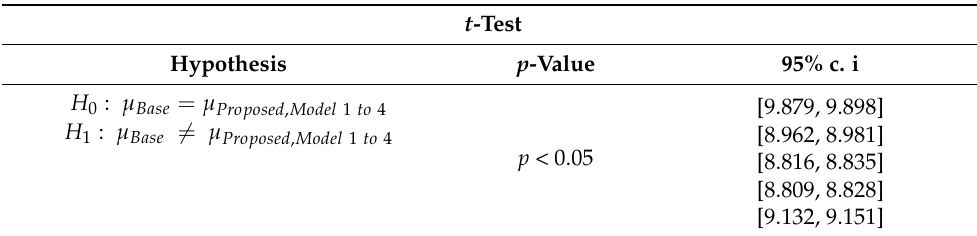
Table 10. Two sample t-test on the study